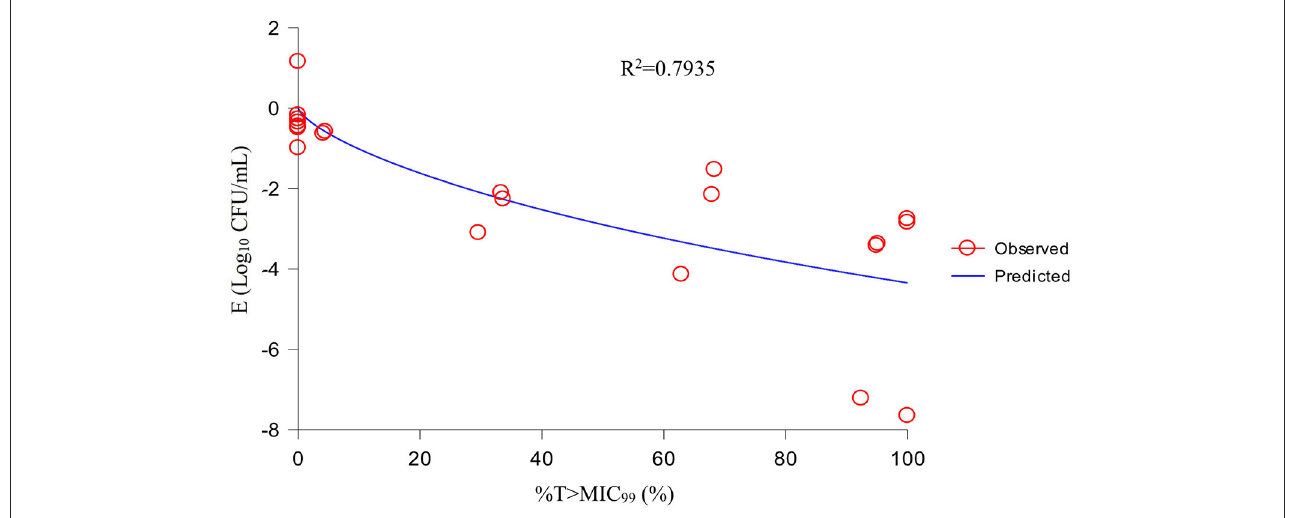
FIGURE5 Fitting curve between %T > MIC 99 and the antibacterial effect.